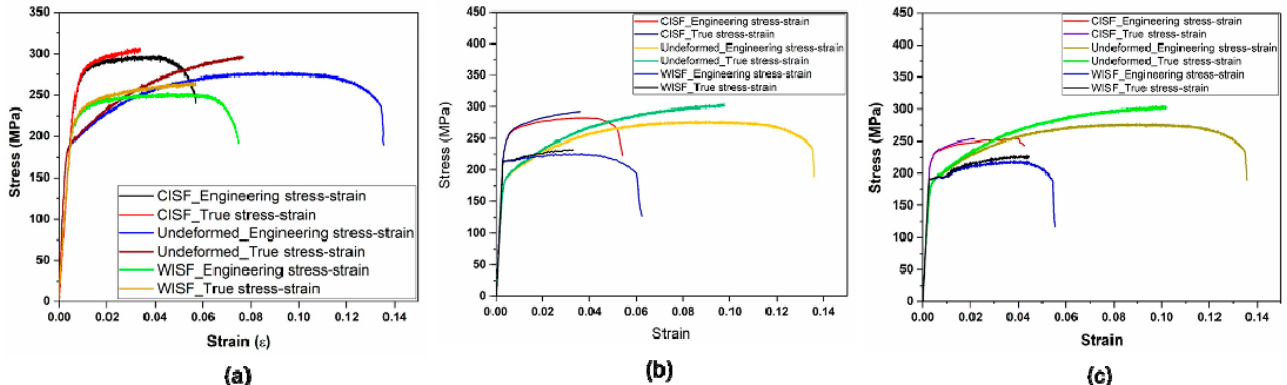
Figure 15. Comparison of tensile properties in the undeformed, CISF, and WISF conditions: ( a ) Along the length of cone; ( b ) Along the circumferential direction; ( c ) In the 45° orientation.